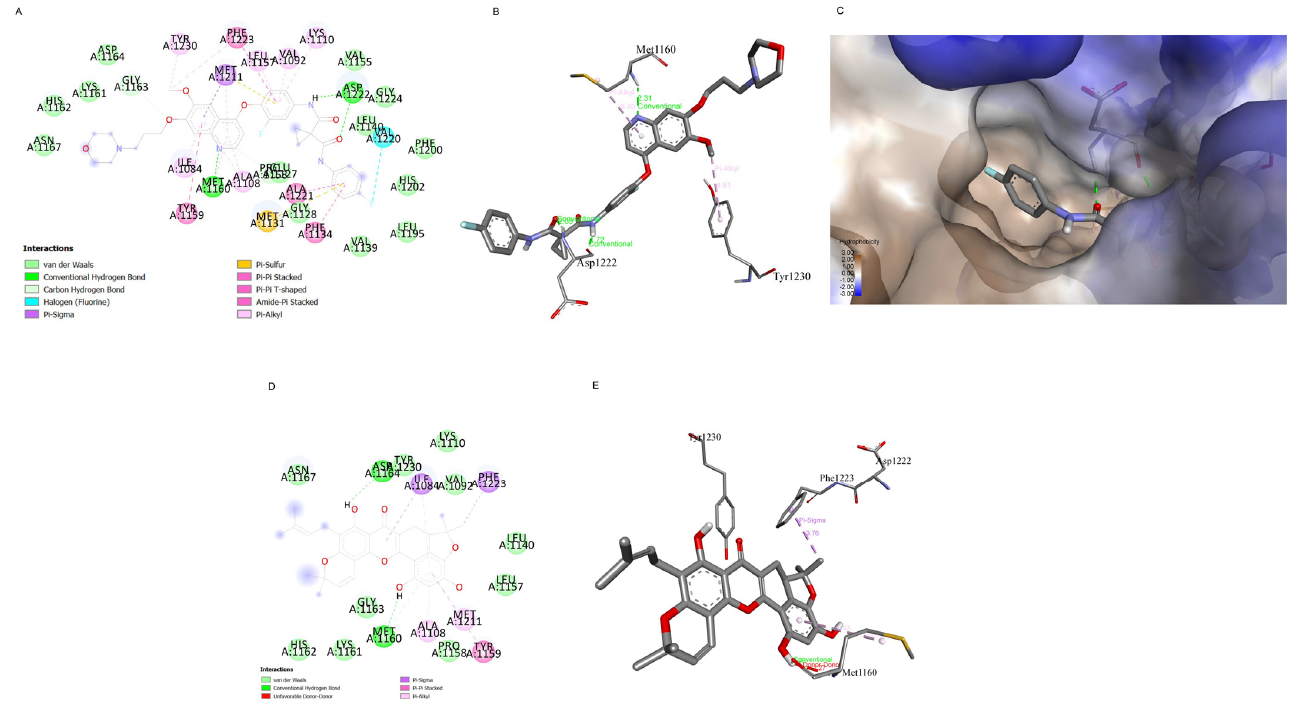
Figure 8. Molecular docking of artonin F interaction with c-Met compared with foretinib interaction